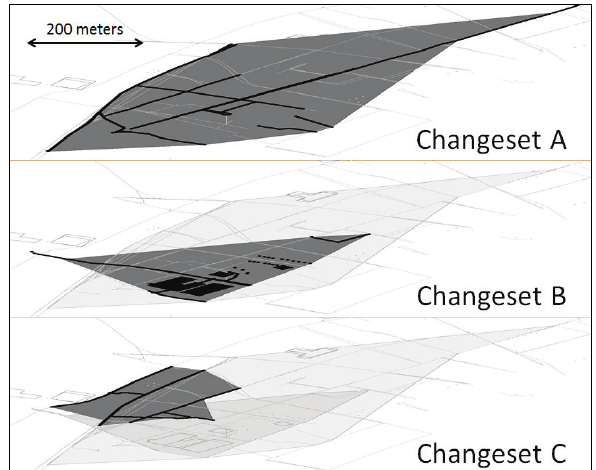
Figure 4: Overlapping concave hulls showing the spatial extent of three sequential editing sessions (changesets A, B and C). Black lines and polygons are new features edited by a contributor. Dark areas represent current changeset and lighter grey areas are previous